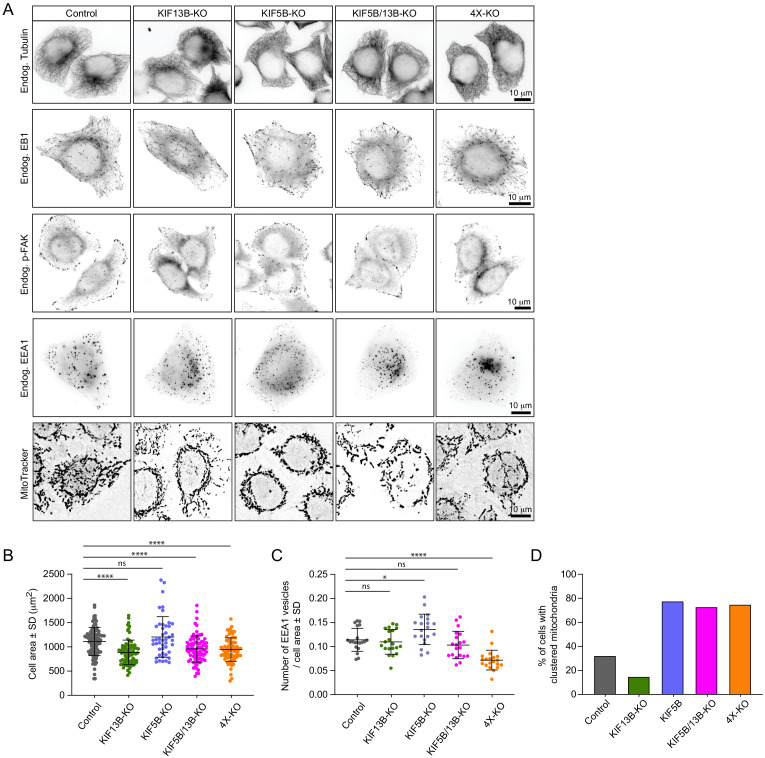
Validation of kinesin knockout cell lines.(A) Representative immunofluorescence images showing the effect of the knockout of different kinesins on the MT cytoskeleton, EB1-positive MT plus ends and distribution of focal adhesions, early endosomes and mitochondria. (B–D) Quantification of cell area (B), number of EEA1-positive vesicles (C) and percentage of cells with clustered mitochondria (D) in the different knockout cell lines. B: n = 104, 81, 45, 81 and 81 cells, respectively. C and D: n = 20 in all conditions. Mann-Whitney U test: ****p<0.0001, ***p=0.0009, *p=0.02, ns, no significant difference.Figure 2—figure supplement 1—source data 1.An Excel sheet with numerical data on the quantification of the effect of kinesin silencing on cell area, number of EEA1 vesicles and mitochondria clustering represented as plots in Figure 2—figure supplement 1B–D.